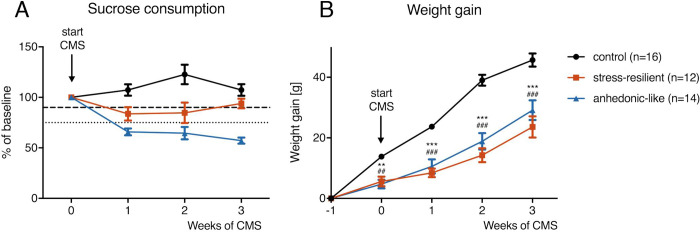
Effects of chronic mild stress on sucrose consumption and body weight.A). Sucrose consumption survey over 3 weeks of CMS demonstrates that 53.8% (14/26) of the animals responded to stress with anhedonic behavior characterized by a >25% within-subject decrease in sucrose consumption (small dashed lines). 46.2% (12/26) of the CMS exposed animals were classified stress-resilient, showing a within-subject decrease in sucrose intake of <10% (wide dashed lines). Hedonic-like behavior was present in all unstressed control rats. B) Stressed rats gained significantly less body weight during three weeks of CMS compared to controls (Repeated measures ANOVA: F2,39 = 26.44, P<0.0001). CMS = chronic mild stress. Data is shown as mean ± SEM. **<0.01, ***<0.001 (control vs. anhedonic-like), ##<0.01, ###<0.001 (control vs. stress-resilient), repeated measures ANOVA followed by Sidak’s multiple comparisons test.